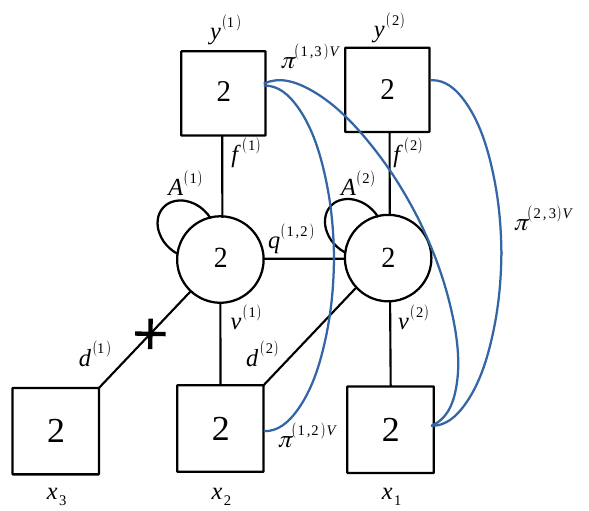
Figure 19 . The quiver diagram representation of E [2 ; 1] [USp(6)]. The fugacity corresponding to each gauge/(cid:13)avor node is also